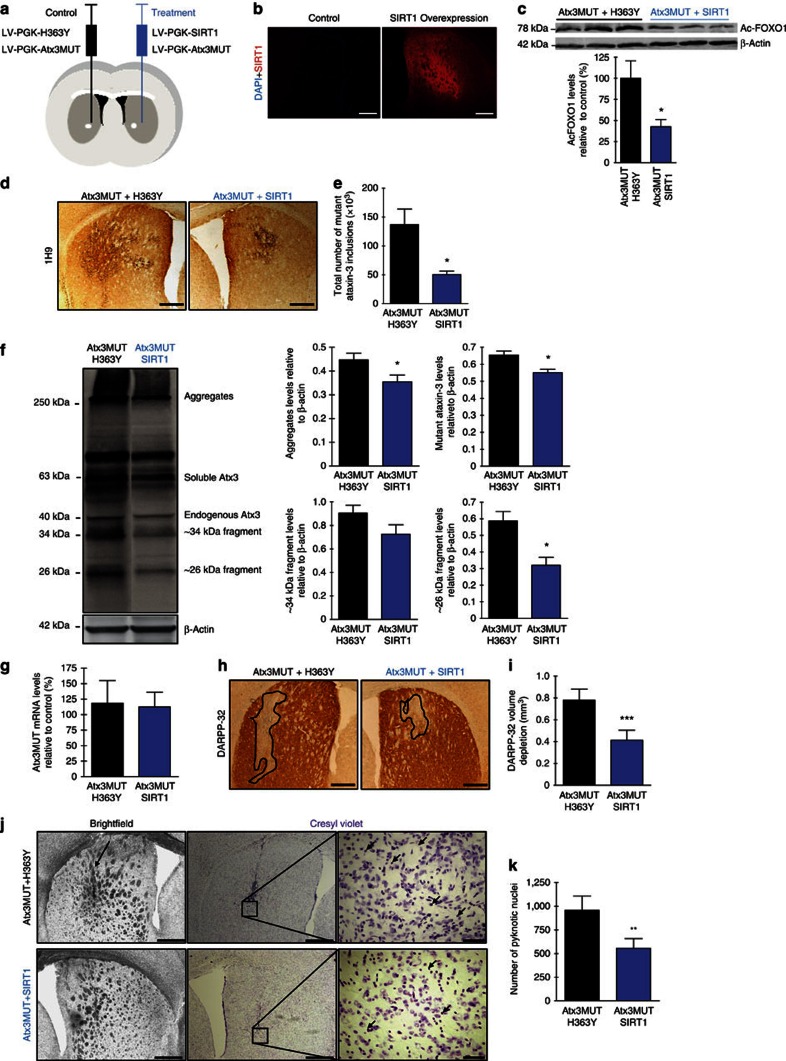
SIRT1 overexpression reduces mutant ataxin-3 toxicity and neuronal dysfunction in a striatal lentiviral model of MJD.(a) Schematic representation of the strategy used to create in vivo striatal lentiviral model of MJD and to overexpress SIRT1/H363Y. Five-week-old C57Bl/6J mice were bilaterally injected with lentiviral vectors encoding for mutant ataxin-3. In the left hemisphere were co-injected lentiviral vectors encoding for H363Y and in the right hemisphere for SIRT1. Four weeks after the surgery, mice were euthanized. (b) SIRT1 immunoreactivity in the striatum of animals of the striatal lentiviral model of MJD co-injected with H363Y or SIRT1 versus a control animal. DAPI, blue, nuclei. Scale bar, 500 μm. (c) Acetylated Forkhead box protein O1 (FOXO1) levels are significantly lower in the striata of lentiviral model of MJD when the active form of SIRT1 was overexpressed, in comparison with control side where the inactive form of SIRT1 was overexpressed. (d) With an anti-ataxin-3 antibody (Ab 1H9), total number of mutant ataxin-3 inclusions were counted and are quantified in e. Scale bar, 500 μm. (f) Western blot analysis demonstrated that SIRT1 overexpression significantly reduced several toxic forms of mutant ataxin-3, namely aggregates, soluble form and ∼34 and ∼26 kDa fragments. (g) Quantitative reverse transcriptase–PCR analysis of Atx3MUT mRNA. (h) DARPP-32 staining revealed a major loss of DARPP-32 immunoreactivity in the striatal hemisphere co-infected with mutant ataxin-3 and H363Y. Scale bar, 500 μm. This was quantified in i as depleted volume of DARPP-32 staining. (j) Cresyl violet staining indicating pyknotic nuclei in both hemispheres. A higher number of pyknotic nuclei were visible around the injection site area in the H363Y-transduced hemisphere. Scale bar, 500 μm (brightfield and left cresyl violet) and 50 μm (right cresyl violet). This was quantified in k. Data represent mean±s.e.m. *P<0.05, **P<0.01 and ***P<0.001 compared with non-treated hemisphere. (c,e–g,i,k) Paired Student's t-test. n=4.